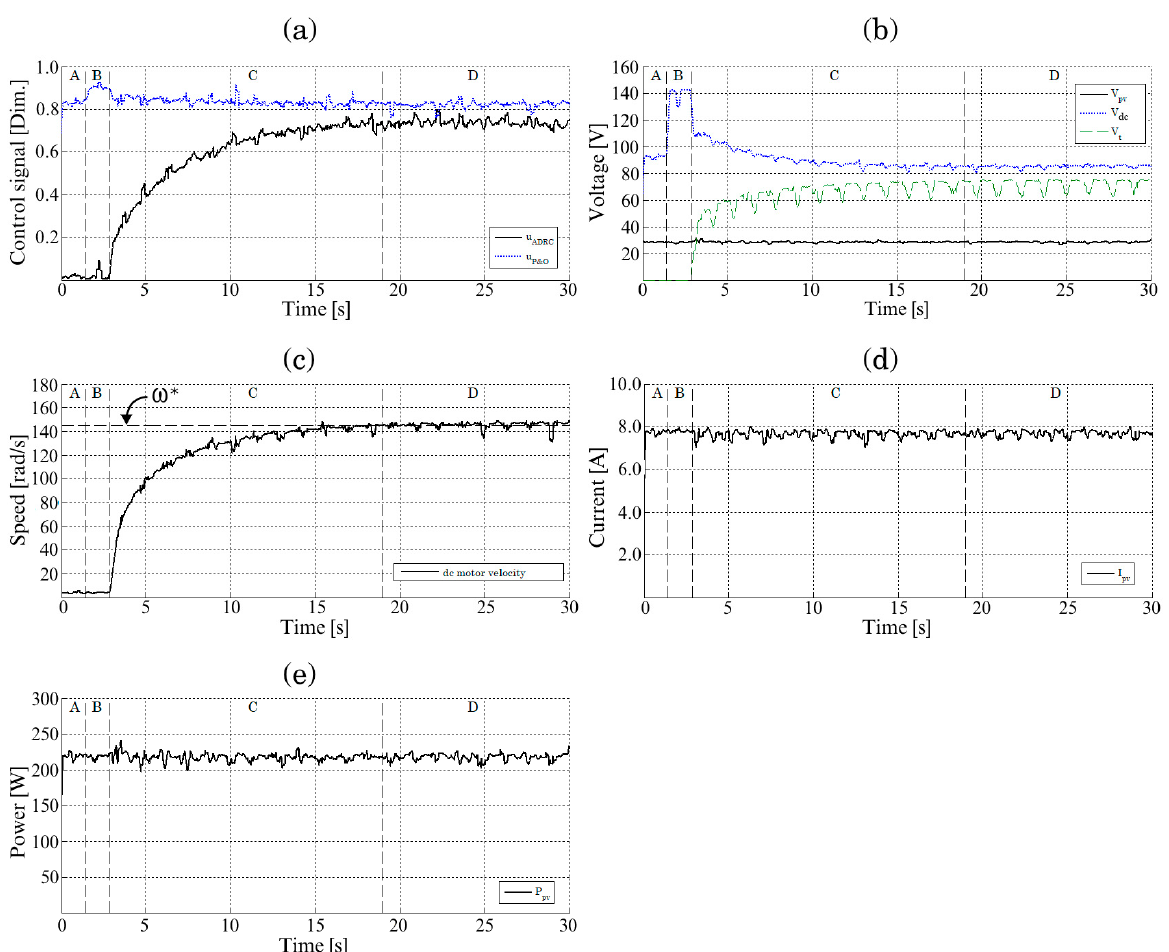
Figure 21. PV system behavioral with I rr = 1186 W/m 2 ( a ) P&O algorithm and ADRC approach control signals; ( b ) PV cells, DC bus and DC motor terminals voltages; ( c ) DC motor angular speed ( d ) PV cells current; and ( e ) PV cells power.